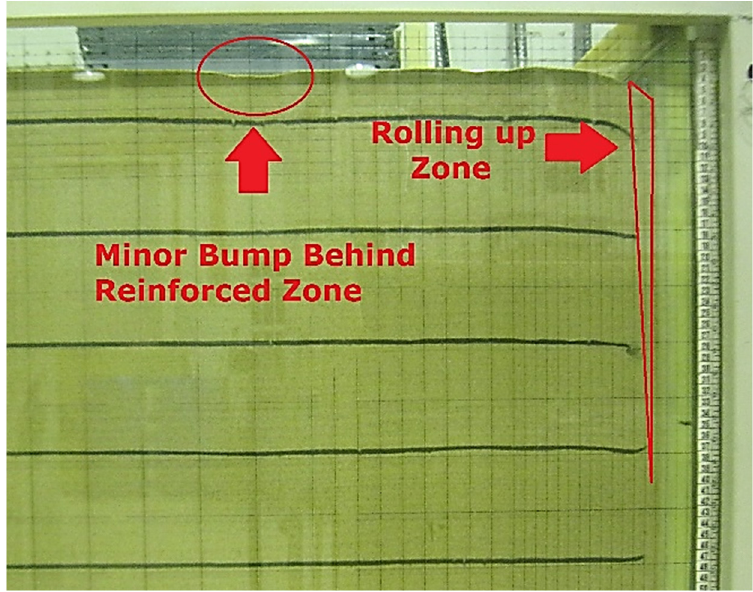
Figure 16. Settlements behind the wall after 120 cycles for geogrid-reinforced. The settlements behind the wall at the soil surface were measured using close-up images with the help of meshed side glass. The variation of normalized settlements (S g /H) versus normalized distance from the wall (x/H) at the end of the loading cycles of four tests is shown in Figure 17. As can be seen, the geogrid reinforcement significantly reduces the backfill settlement compared to unreinforced backfill by preventing the formation of shear zones behind the wall. This reduction reaches 63% adjacent to the wall. In comparison with honeycomb geocell, geogrid works better in reducing settlements. However, square-shaped geocell has a better performance in this regard.